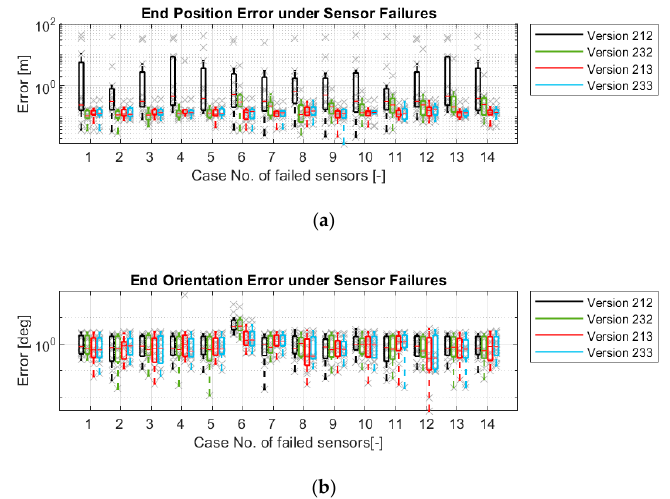
Figure 27. Real driving results of four odometry versions under sensor failures: ( a ) End position errors; ( b ) End orientation errors.